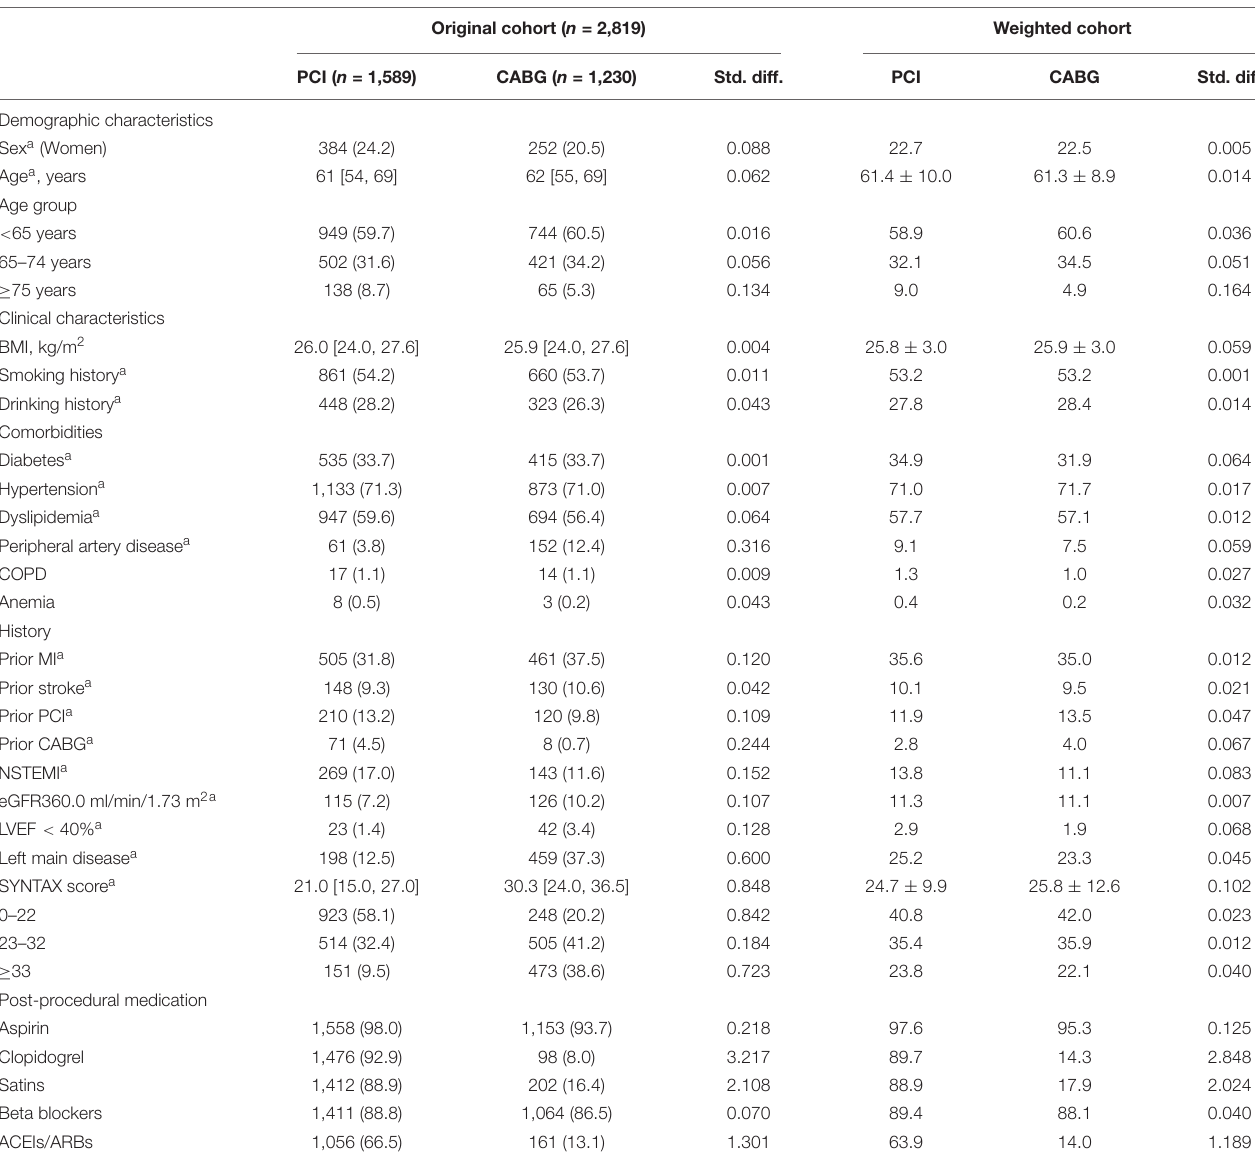
TABLE 1 | Baseline